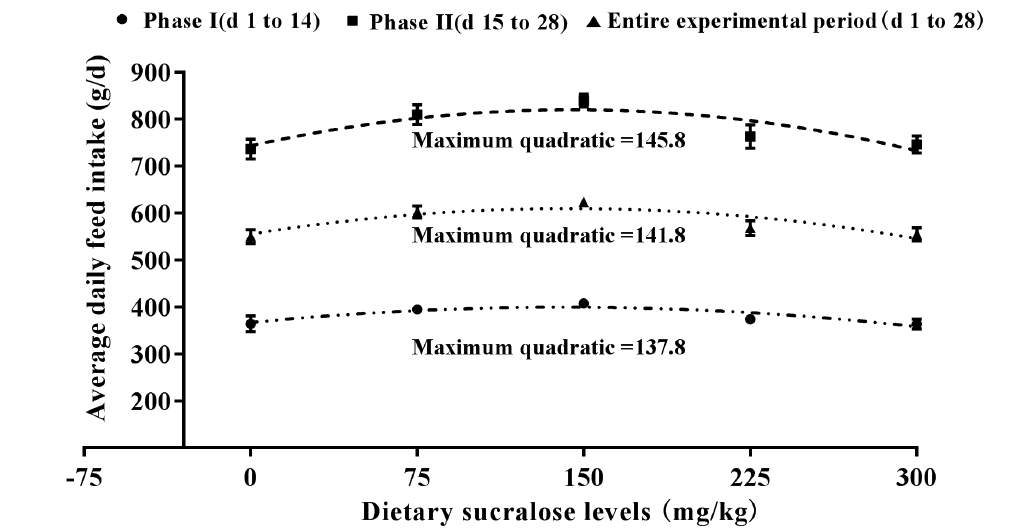
Figure 2. Fitted quadratic plot of average daily feed intake as a function of dietary sucralose for weaned piglets (experiment 2). The optimal dietary sucralose for phase I was 137.8 mg/kg (y = –0.0017x 2 +0.4684x+366.69, R 2 = 0.81, p<0.01), and the SE for the estimated parameters of a (–0.0017), b (0.4684), c (366.69) were 0.0005, 0.1545, 9.783, respectively. The optimal dietary sucralose for phase II was 145.8 mg/kg (y = –0.0036x 2 +1.0497x+744.09, R 2 = 0.78, p<0.01), and the SE for the estimated parameters of a (–0.0036), b (1.0497), c (744.69) were 0.0010, 0.3169, 20.06, respectively. The optimal dietary sucralose for entire experiment period was 141.8 mg/kg (y = –0.0027x 2 +0.7655x+555.74, R 2 = 0.78, p<0.01), and the SE for the estimated parameters of a (–0.0026), b (0.7655), c (555.74) were 0.00068, 0.2114, 13.38, respectively. SE, standard